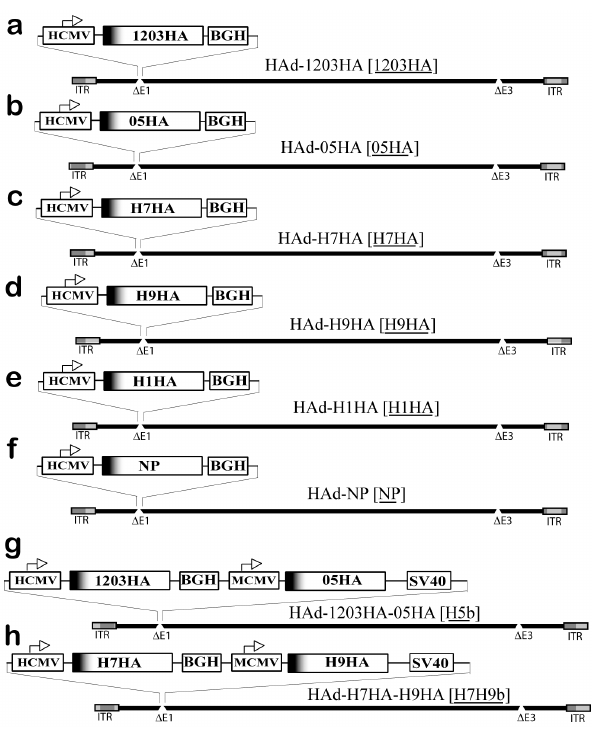
Figure 1. Diagrammatic representation of adenovirus vector constructs used in the study. (a). HAd-1203HA [1203HA] human adenovirus serotype 5 (HAdV5) vector containing the hemagglutinin (HA) gene of clade 1 H5N1 influenza virus (A/Vietnam/1203/2004); (b). HAd-05HA [05HA], HAdV5 vector containing the HA gene of clade 2 H5N1 influenza virus (A/Indonesia/05/2005); (c). HAd-H7HA [H7HA], HAdV5 vector containing the HA gene of A/Netherlands/219/2003 (H7N7) virus; (d). HAd-H9HA [H9HA], HAdV5 vector containing the HA gene of A/chicken/Hong Kong/G9/1997 (H9N2) virus; (e). HAd-H1HA [H1HA], HAdV5 vector containing the HA gene of A/California/04/2009 (H1N1) virus; (f). HAd-NP [NP], HAdV5 vector containing the nucleo- protein (NP) gene of clade 1 H5N1 influenza virus (A/Vietnam/1203/ 2004); (g). HAd-1203HA-05HA [H5b], HAdV5 vector containing the HA genes of clade 1 and clade 2 H5N1 influenza viruses; and (h). HAd- H7H9b [H7H9b], HAdV5 vector containing the HA genes of A/ Netherlands/219/2003 (H7N7) and A/chicken/Hong Kong/G9/1997 (H9N2) viruses. HCMV, human cytomegalovirus immediate early promoter; MCMV, mouse cytomegalovirus immediate early promoter; BGH, bovine growth hormone polyadenylation signal; SV40, simian virus 40 polyadenylation signal; E1, early region1; E3; early region 3;